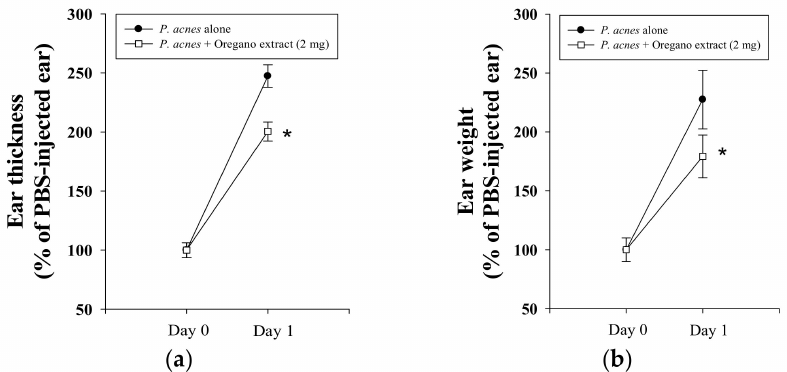
Figure 2. Effects of EOE on P. acnes -induced mouse ear edema. The inhibitory effects of EOE on P. acnes -induced ear edema in mice were assessed by measuring ear thickness ( a ) and ear biopsy weight ( b ). Each value represents the mean ± SD of three independent experiments. The value with a symbol (*) is significantly different from each other at p <